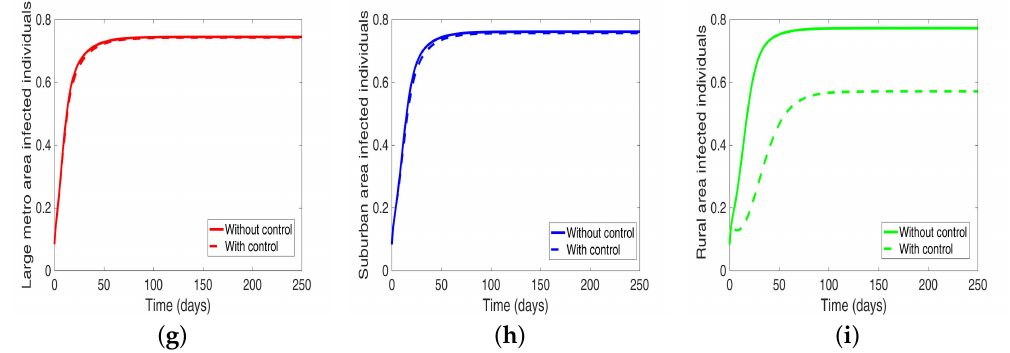
Figure 10. MRSA model simulation with movement, disease, and behavioral control in large metro area only ( a – c ). Movement, disease, and behavioral control in suburban area only ( d – f ). Movement, disease, and behavioral control in rural area only ( g – i ). ( a ) Infected individuals in the large metro area. ( b ) Infected individuals in the suburban area. ( c ) Infected individuals in the rural area. ( d ) Infected individuals in the large metro area. ( e ) Infected individuals in the suburban area. ( f ) Infected individuals in the rural area. ( g ) Infected individuals in the large metro area. ( h ) Infected individuals in the suburban area. ( i ) Infected individuals in the rural area. Parameter values used are given in Tables 2–4.